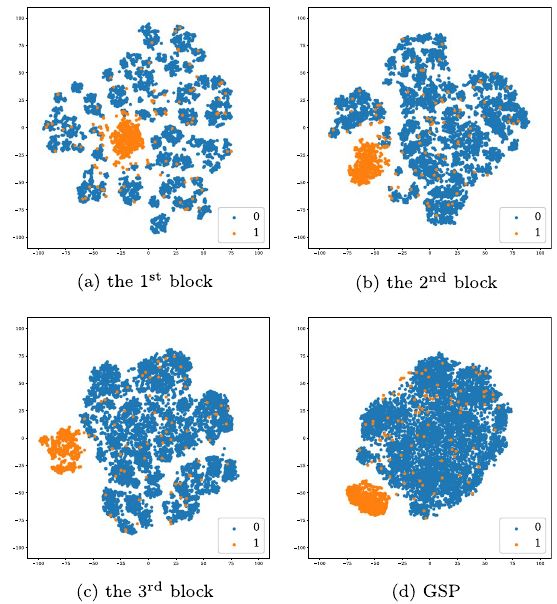
Fig. 5 Output visualization of the intermediate